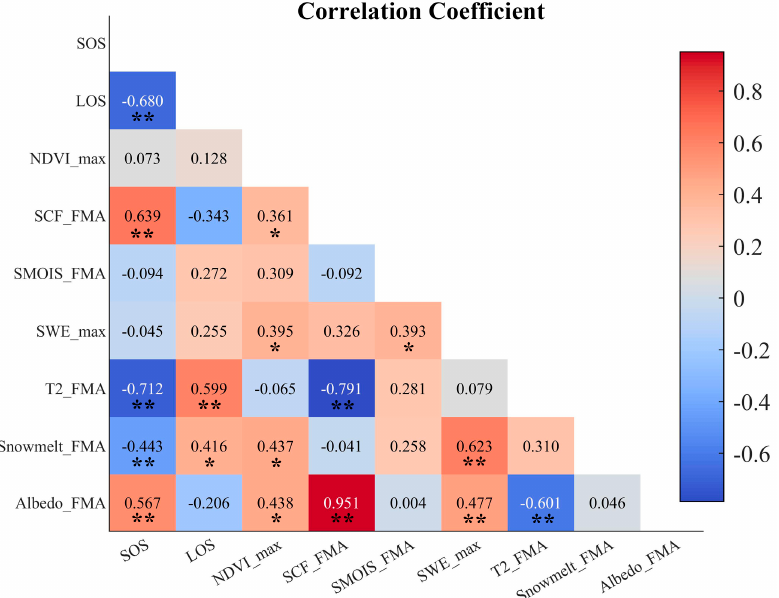
Figure 6. Correlation between land surface phenology metrics and climatic factors (* and ** indicate p < 0.05 and p < 0.01, respectively).